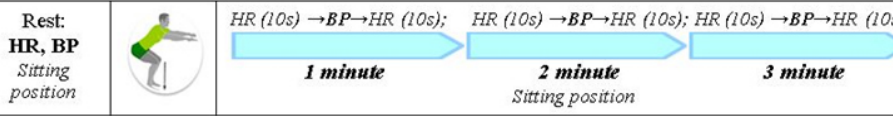
Fig. 1. Scheme of the Martine